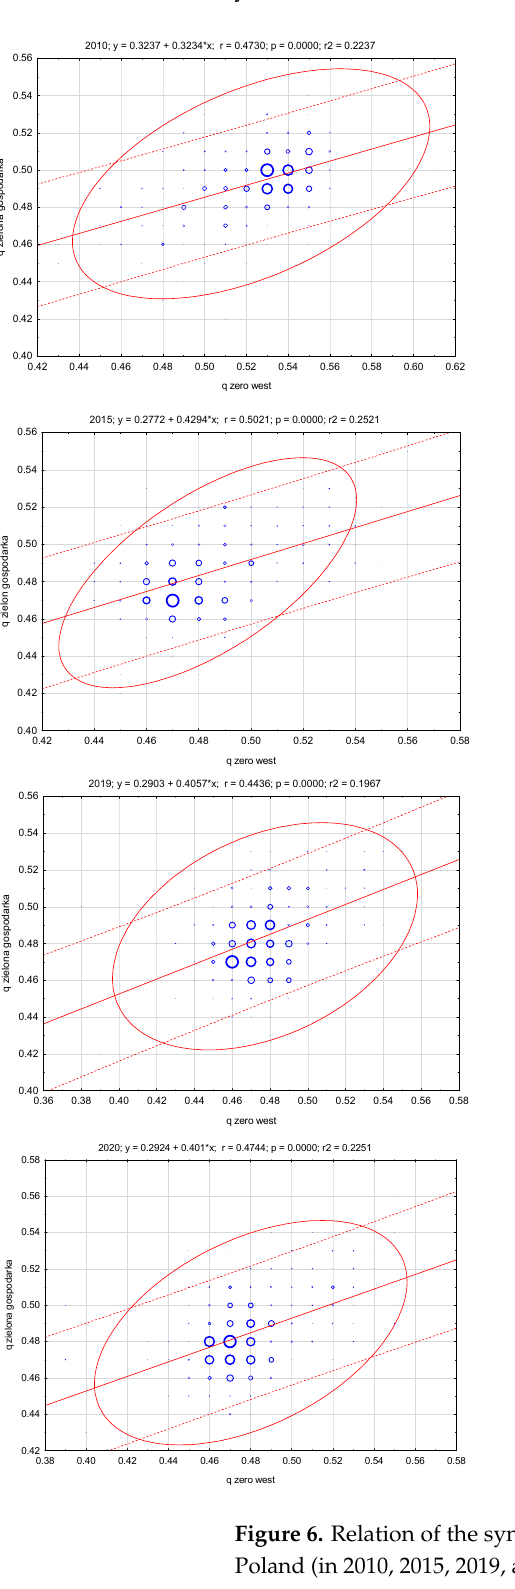
Figure 5. Diversity (spread) of the synthetic measure, waste management and green economy in districts in Poland (in 2010, 2015, 2019, and 2020). Source: Own study. The Pearson correlation coefficient between the value of the measures analyzed in subsequent years was 0.473 and 0.474 for 2010 and 2020, respectively. The pocket graph shows statistically similar clusters of districts (including outliers, whose graphical form in the later years 2010 and 2015 as well as 2019 and 2020 indicate their slight differentiation) (Figure 6).